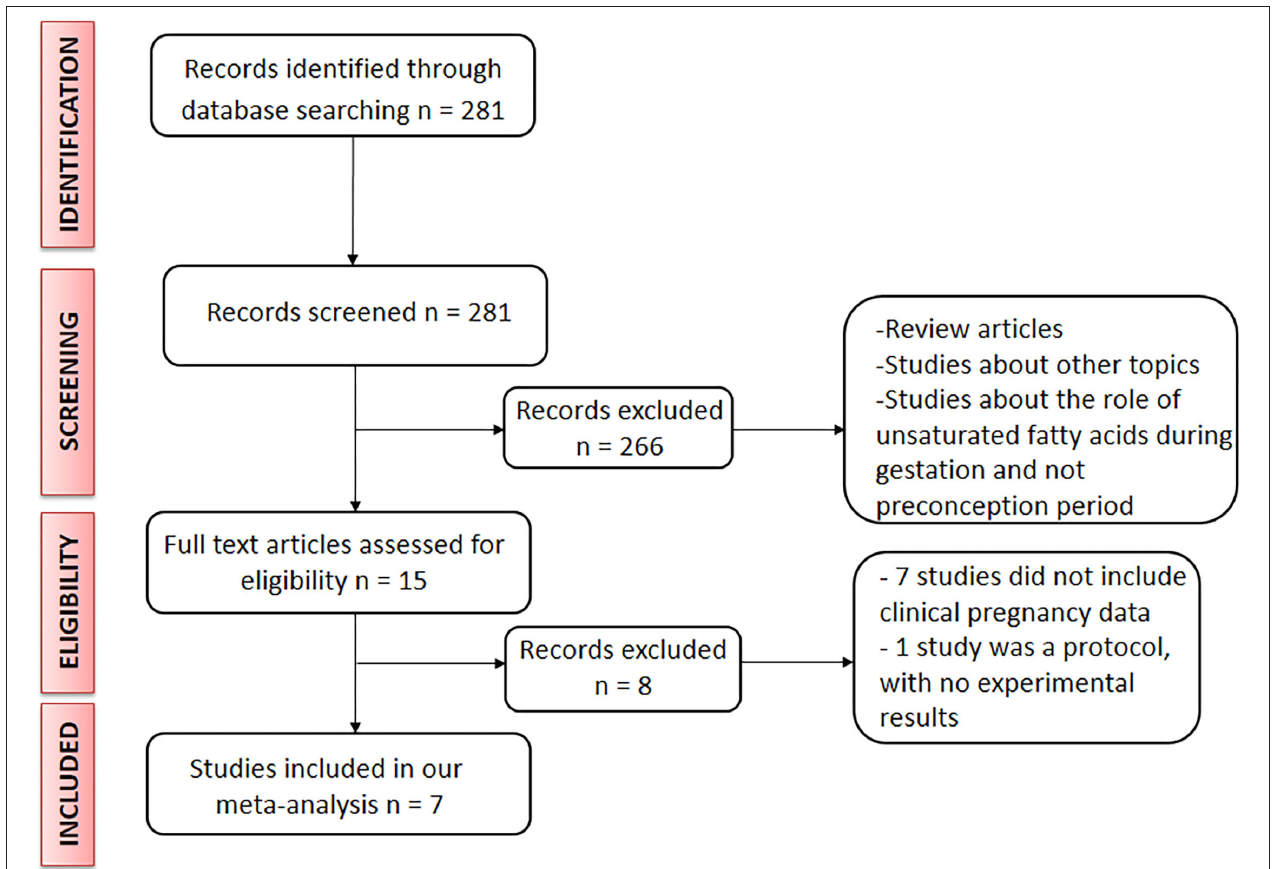
FIGURE 1 | Flow diagram of selection of studies eligible for our